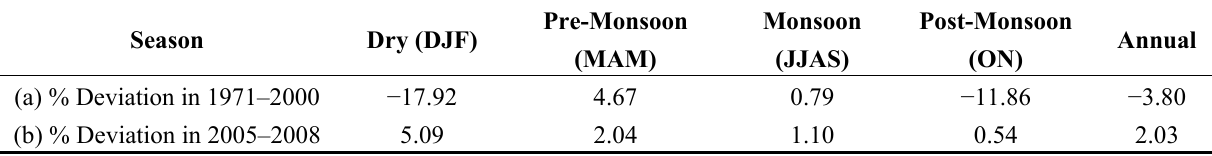
Table 3. Seasonal average deviation (%) from observed temperature: ( a ) calculated for model outputs; ( b ) calculated for applied change